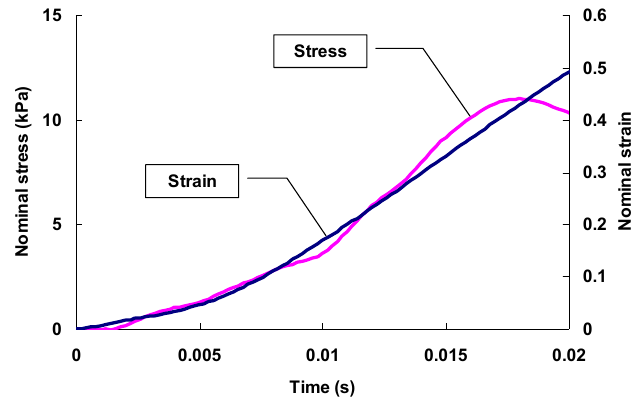
Fig. 2: Typical time course of tensile stress and strain responses obtained at the fastest loading rate (25 s -1 ).